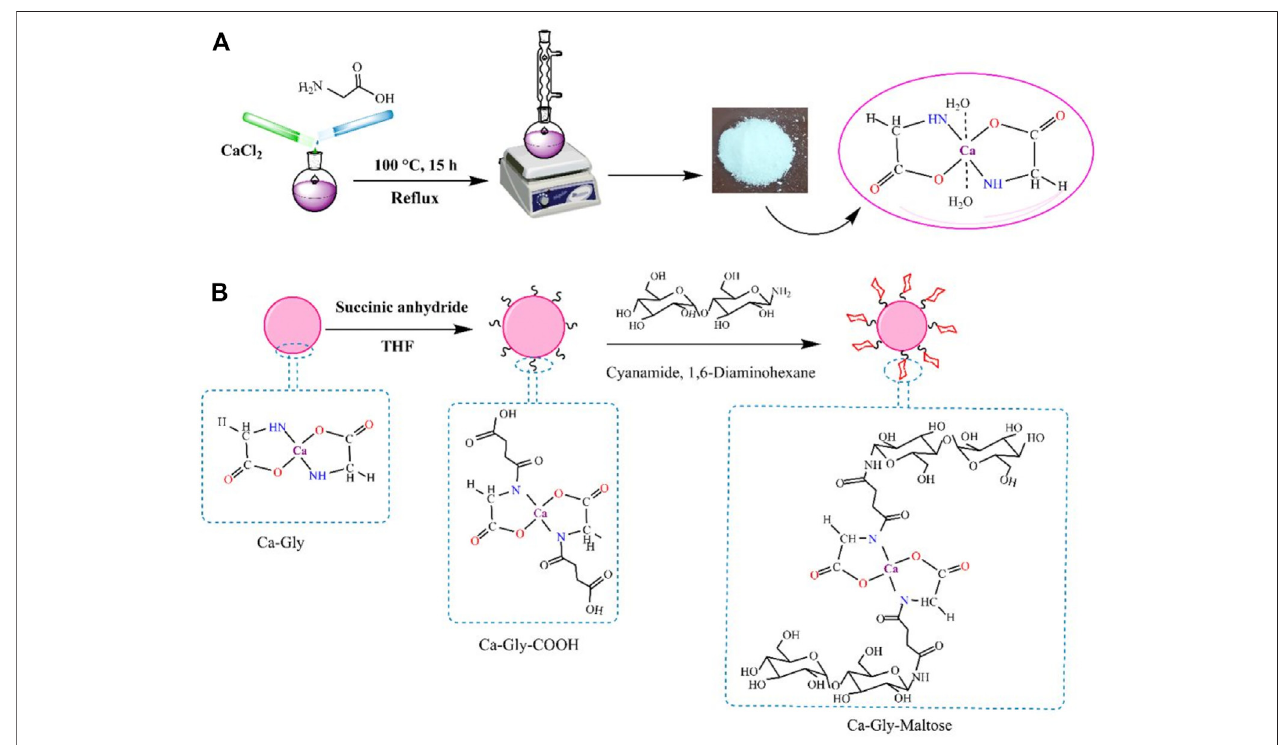
FIGURE 1 | Schematic illustration of the (A) Synthesis pathway of Ca-Gly and (B) surface modi fi cation and fabrication of Ca-Gly-Maltose.